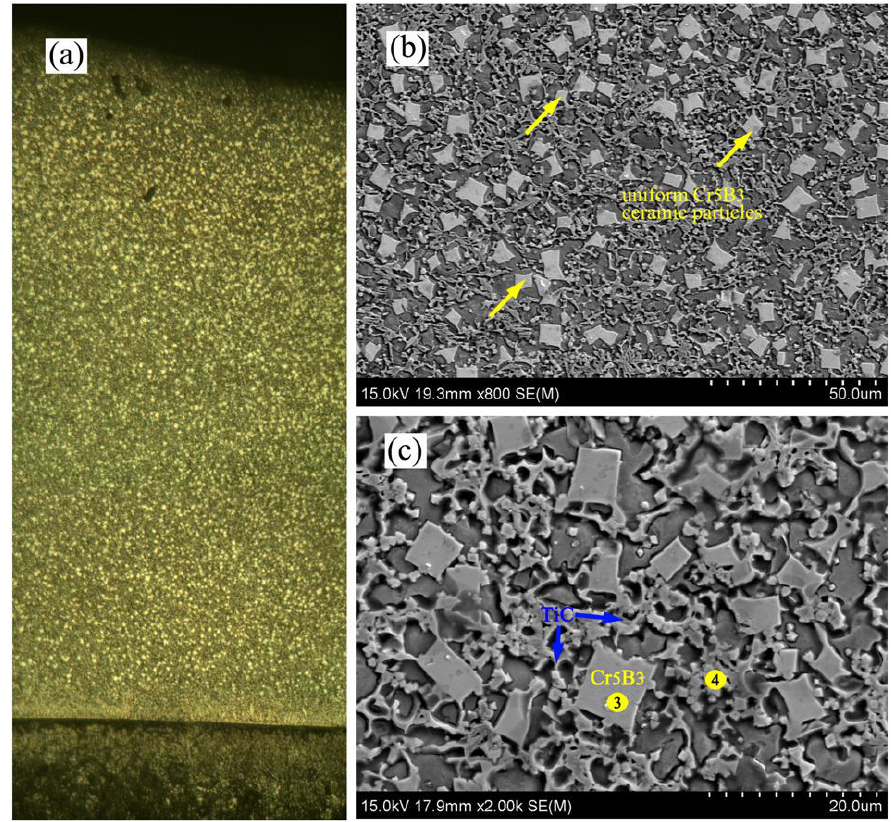
Figure 8: Microstructure of in-situ synthesized ceramic particles in Ni60-20WC-2Ti coating (a): cross-section; (b): magnified SEM; (c): high magnification microstructure [43]